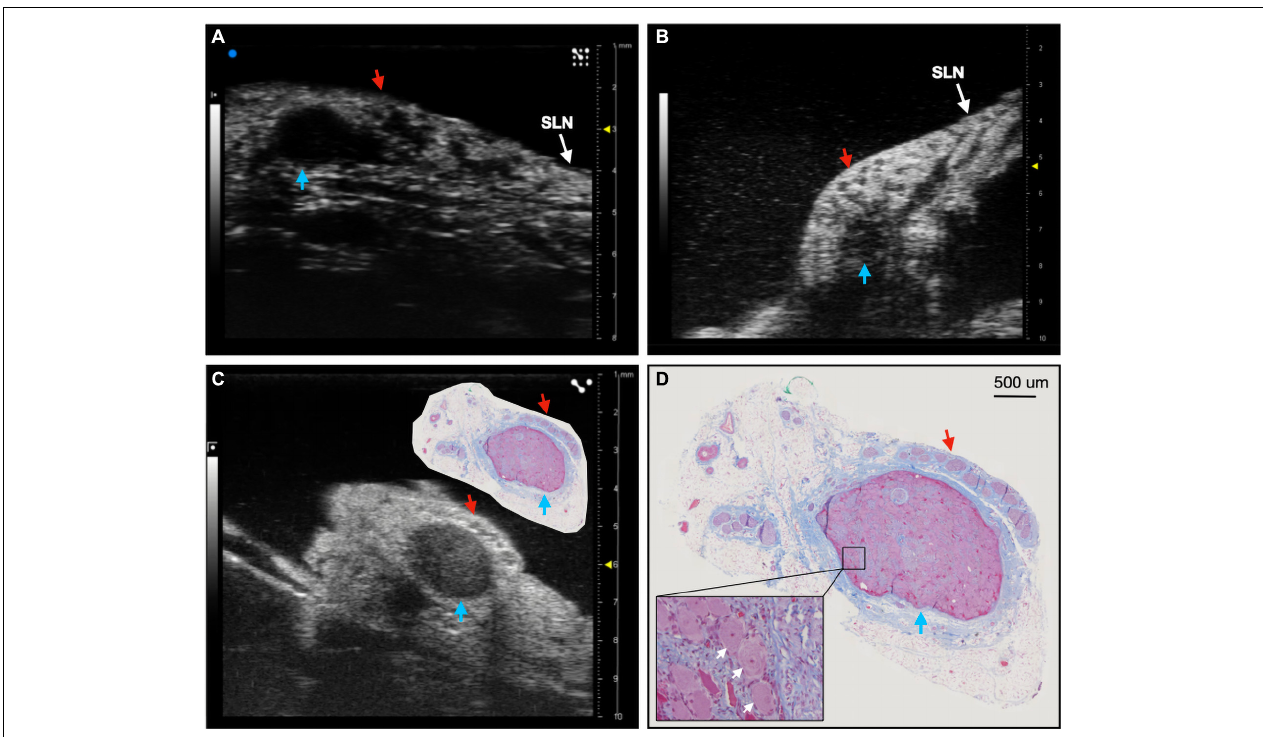
FIGURE 2 | Ultrasound of the nodose ganglia in two live, and one cadaver subject ( n = 3). Blue arrows indicate the hypoechoic pseudo-unipolar cell region of the nodose ganglia, red arrows indicate the motor efferent region fascicles. (A,B) Ultrasound of the nodose ganglia and superior laryngeal nerve (SLN) in vivo. (C) Ultrasound of the nodose ganglion in a cadaver with paired histology slice demonstrating the pseudo-unipolar cell region (D) Histology slice at a larger scale with zoomed region of pseudo-unipolar cells (white arrows) and surrounding satellite